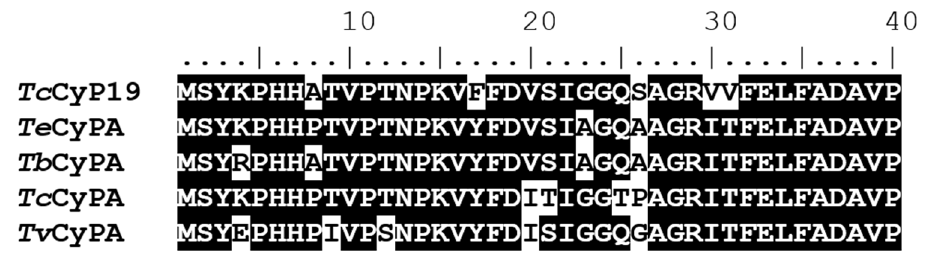
Figure 1. Secreted Kinetoplastid cyclophilins protein sequences. The first 40 amino acid residues of T. cruzi cyclophilin 19 (Acc No. AF191832), were aligned with the protein sequences of T. evansi ( Te CyPA; Acc No. ABI20435), T. brucei CyPA ( Tb CyPA; Acc No. U68270), T. congolense ( Tc CyPA; Acc No. U68268), T. vivax CyPA ( Tv CyPA; Acc No. U68269). Identical amino acids respect to the Tc CyP19 protein